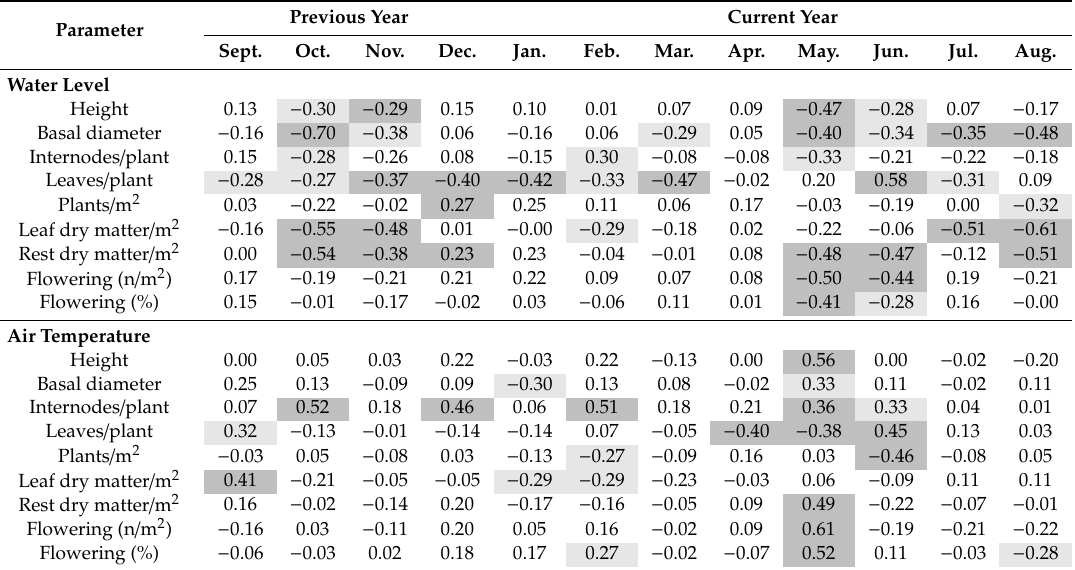
Table 2. Spearman’s correlations between growth and biomass allocation parameters, as well as water levels and air temperatures, for the common reed plants from the lake reed stand (Zadnji Kraj). Parameter